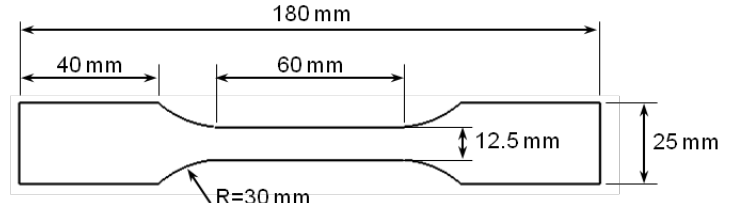
Figure 1. Korean Standard (KS) B0810 13B flat dog-bone specimen.